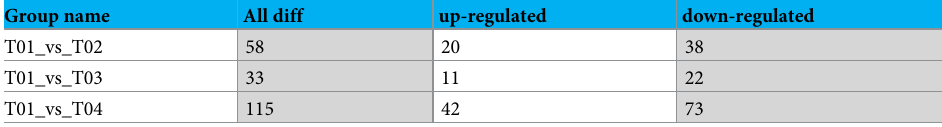
Table 4. Differentially expressed